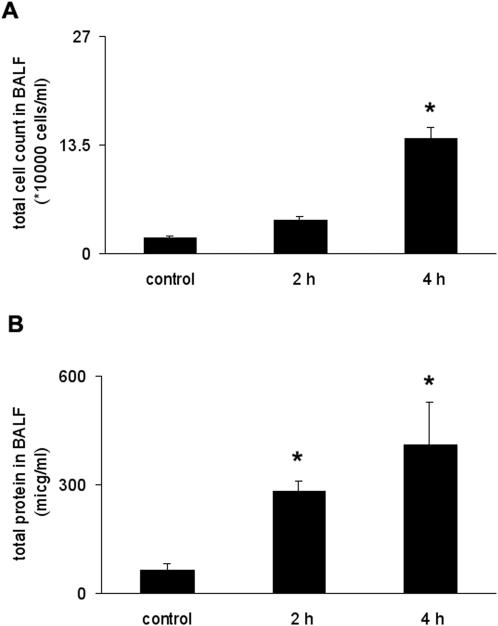
Time course of mechanical ventilation-induced lung injury with high tidal volume.(A) Total cell count increased following ventilation (20 ml/kg) for 2 and 4 hours (*10000 cells/ml). (B) BALF total protein levels (microgram/ml) were augmented by mechanical ventilation. *represents significant differences between ventilated and control animals, p<0.05.